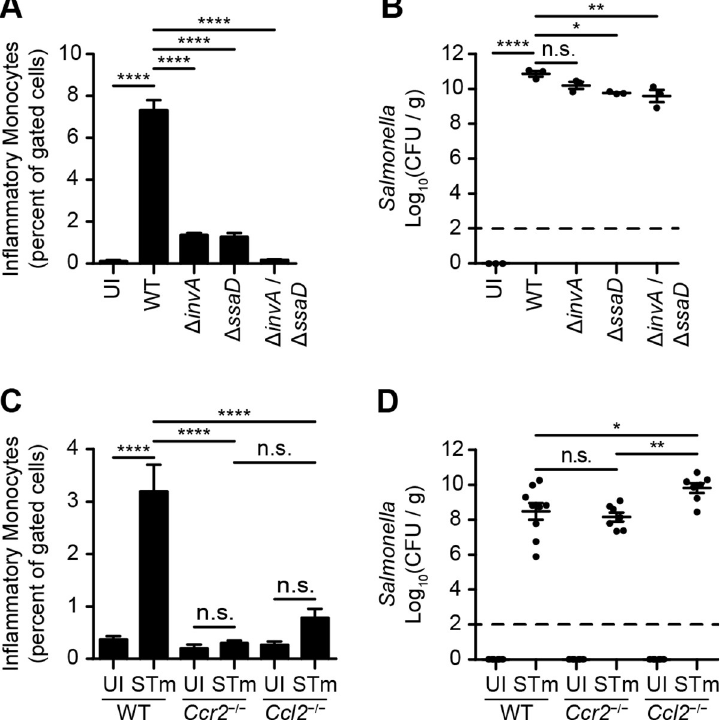
Fig 2. Inactivation of T3SS-1 and T3SS-2 renders STm unable to induce Ccr2 - and Ccl2 -dependent IM recruitment. (A) Percentage of IM among total gated cells in cecal tissues from C57BL/6J mice (n = 3 per group) treated with Sm prior to inoculation with PBS (uninfected; UI) or wild-type (WT) STm, or invA (T3SS-1), ssaD (T3SS- 2), or invA ssaD (T3SS-1 T3SS-2) mutant STm. Ceca were harvested on day 4 after inoculation. Data show mean with SEM and were analyzed by one-way ANOVA with Sidak post hoc test. (B) Corresponding number of STm CFU recovered from cecal contents, normalized to weight. Data show mean with SEM and individual data points, and were analyzed by one-way ANOVA with Sidak post hoc test. (C) Percentage of IM among total gated cells in cecal tissues from C57BL/6J (WT), Ccr2 -/- , and Ccl2 -/- mice (n = 6–9 per group) treated with Sm prior to inoculation with PBS (uninfected, UI) or STm. Ceca were harvested on day 4 after inoculation. Data show mean with SEM and were analyzed by one-way ANOVA with Sidak post hoc test. (D) Corresponding number of STm CFU recovered from cecal contents, normalized to weight. Data show mean with SEM and individual data points, and were analyzed by one-way ANOVA with Sidak post hoc test. Also see S2